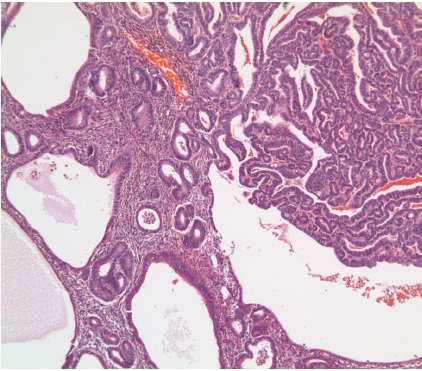
Figure 3: Endometrioid adenocarcinoma (top left) next to normal bowel mucosa (bottom right), that is, no dysplasia of bowel mucosa.